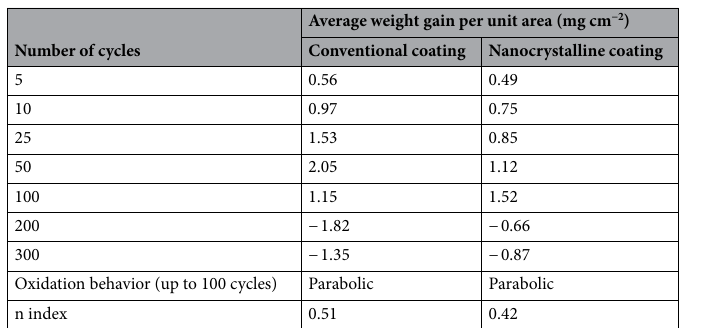
Table 5. Variation of the weight gain per unit area versus the number of oxidation cycles as well the n index (calculated after 100 cycles) for the conventional and nanocrystalline MCrAlY coatings under cyclic oxidation test at 1100